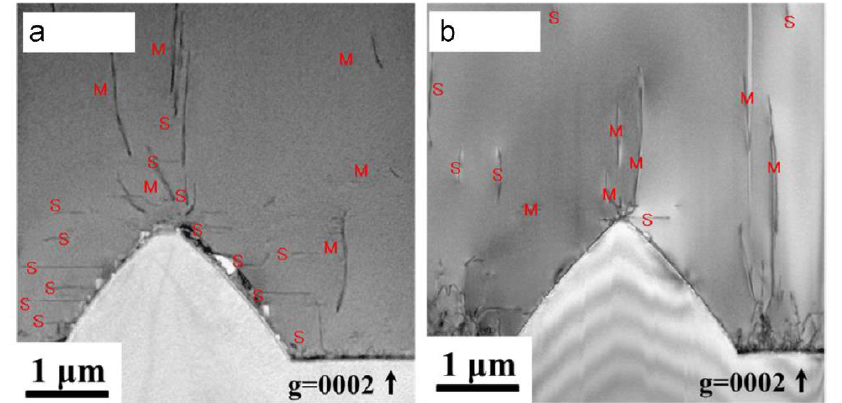
Figure 4. Bright field cross-section TEM images of ( a ) UV-LEDs with GaN nucleation layer and ( b ) UV-LEDs with sputtered AlN nucleation layer, g = 0002. S indicates screw dislocation and M indicates mixed dislocation [26].